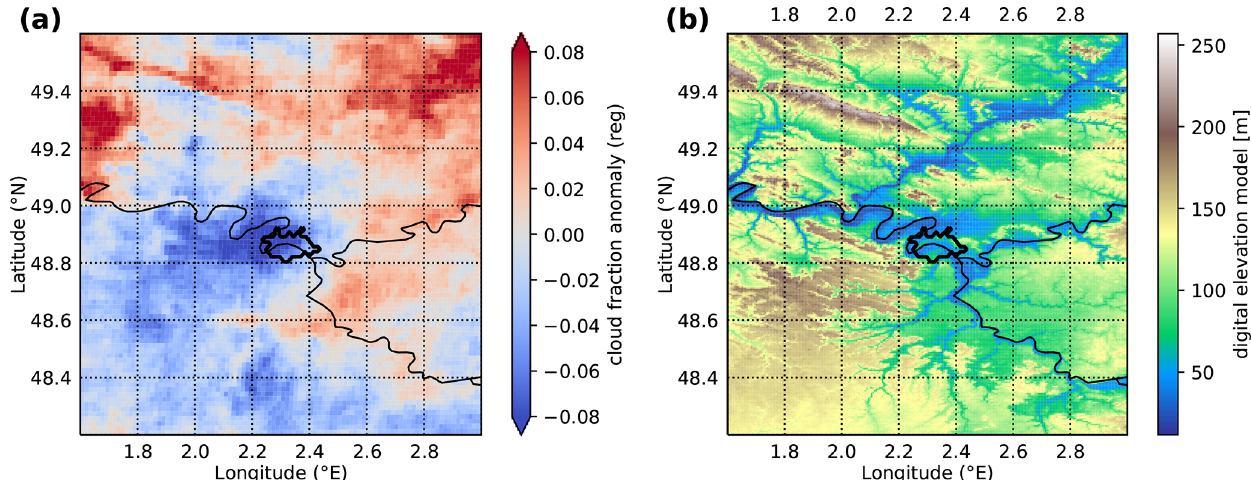
Figure 6. (a) Cloud fraction CF reg anomaly (difference between the cloud fraction of the pixel and the average cloud fraction of the region) from the Regional Empirical Cloud Detection Approach constrained by the following meteorological conditions: low wind speed ( < 3ms − 1 ), low BLH ( < 300m) and high MSL ( > 1020hPa). (b) European Digital Elevation Model with a spatial resolution of 25m. The Seine river is visualised as a black line.